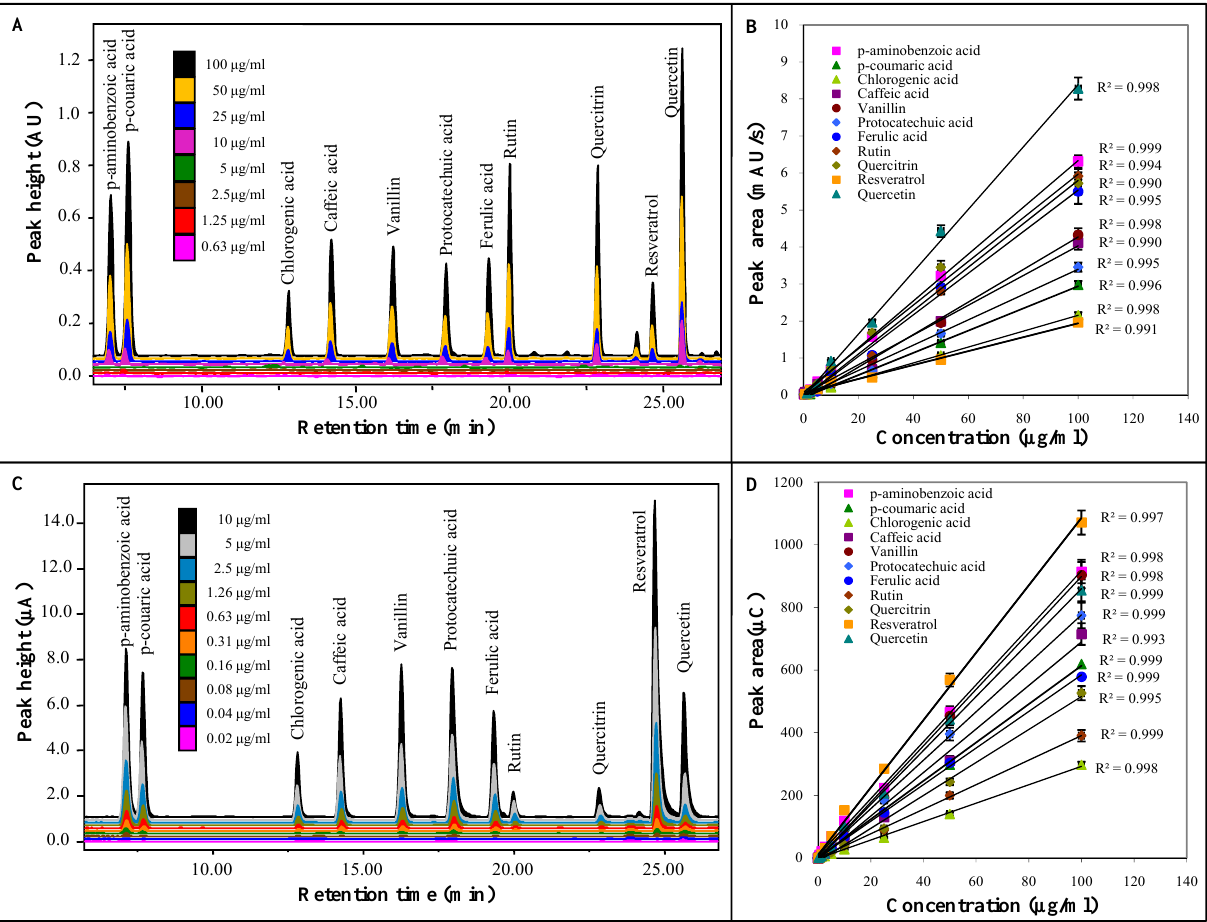
Figure 3. (a) The HPLC-UV chromatogram for determination phenolic compounds. Absorbance shows the quantity of particular substances in samples. (b) Dependence of peak area (mAU/s) on concentration (µg/g) and of single phenols. (c) The HPLC-ED chromatogram for determination of phenolic compounds. (c) Dependence of concentration (µg/g) and peak area (µC) of single